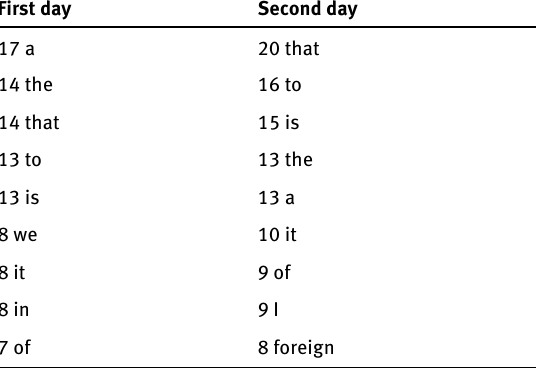
Table 1: Two-day comparison of variation in word choice